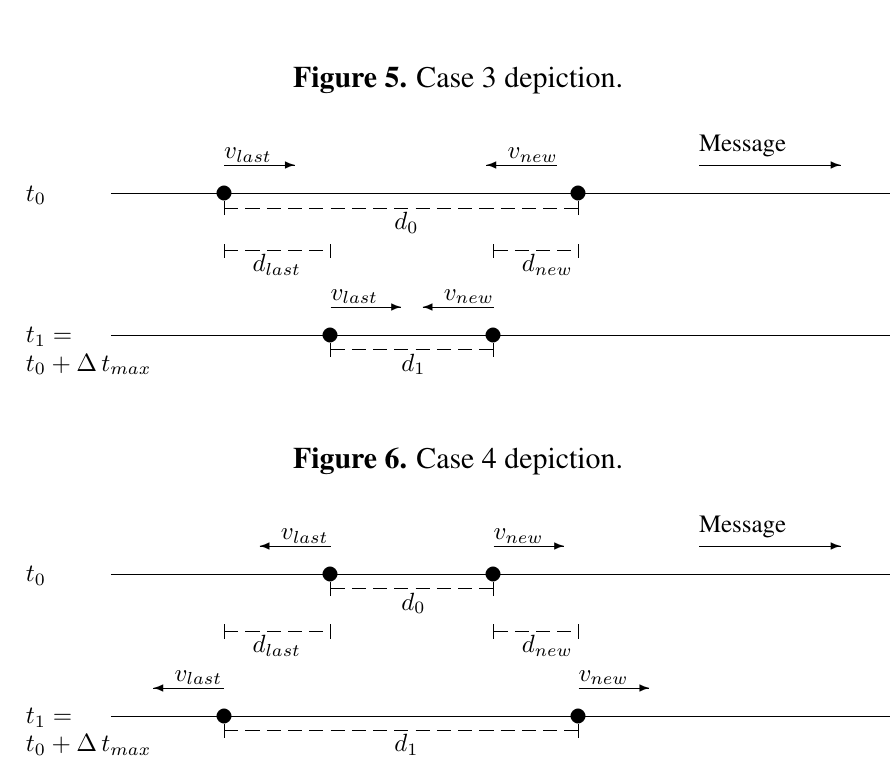
Figure 5. Case 3 depiction.